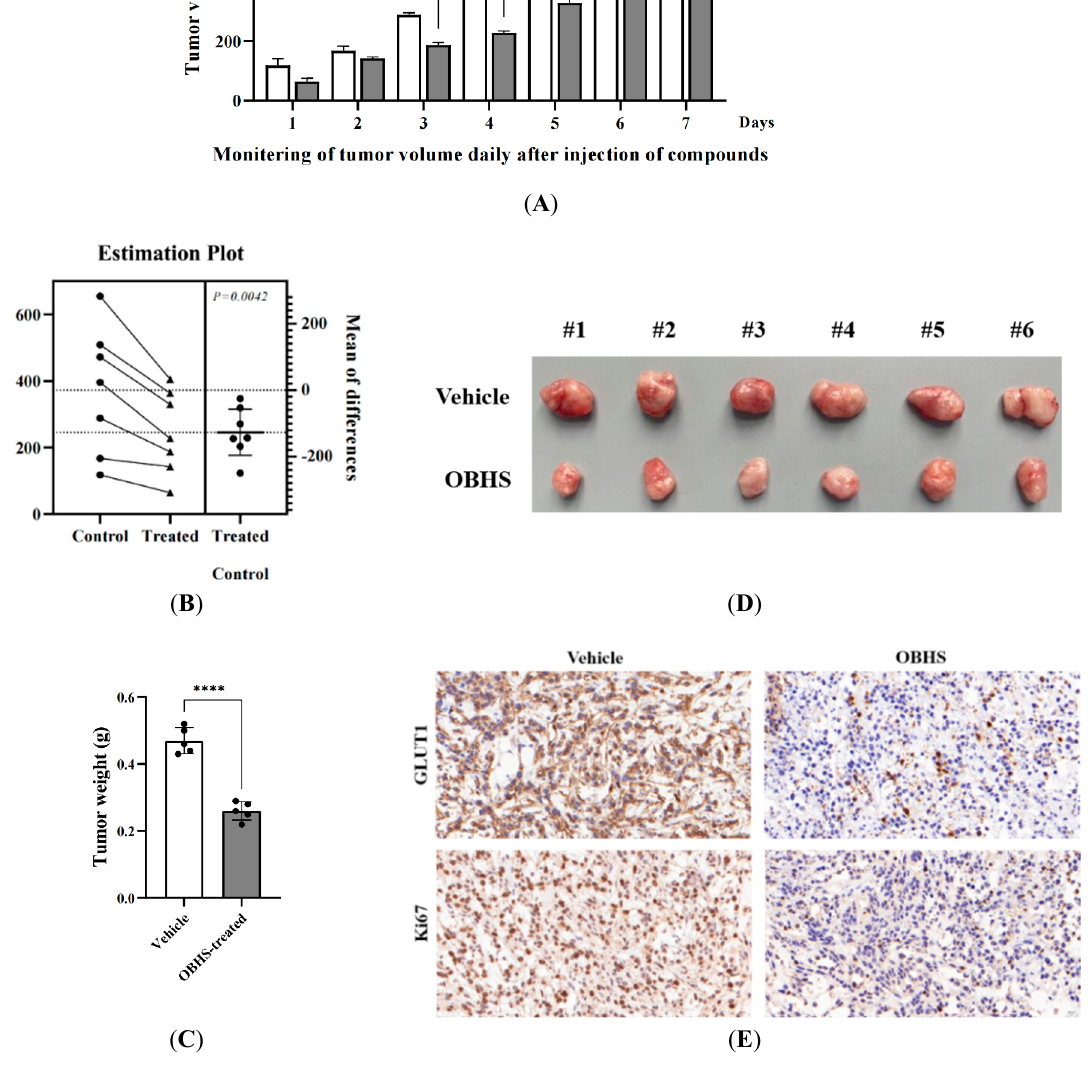
Figure 6. OBHS significantly delayed disease progression in the MCF-7 breast cancer mouse model. ( A ) OBHS suppressed the tumor growth in the MCF-7 tumor mouse model. The average tumor sizes of the vehicle ( n = 6) and OBHS-treated groups ( n = 6) were plotted after inoculation. Data are represented as mean ± SD, and the statistical analysis between vehicle and drug-treated groups was performed by a two-way ANOVA with Tukey’s test and ( B ) paired-sample t test. p values are indicated. ** p < 0.01, *** p < 0.001, and **** p < 0.0001. ( C ) OBHS-treated MCF-7 cells had slower growing and smaller tumors. ( D ) Representative tumor sizes after seven rounds of drug treatment. ( E ) IHC for Ki67 and GLUT1 in subcutaneous xenograft tumors. Scale bars, 20 µm.